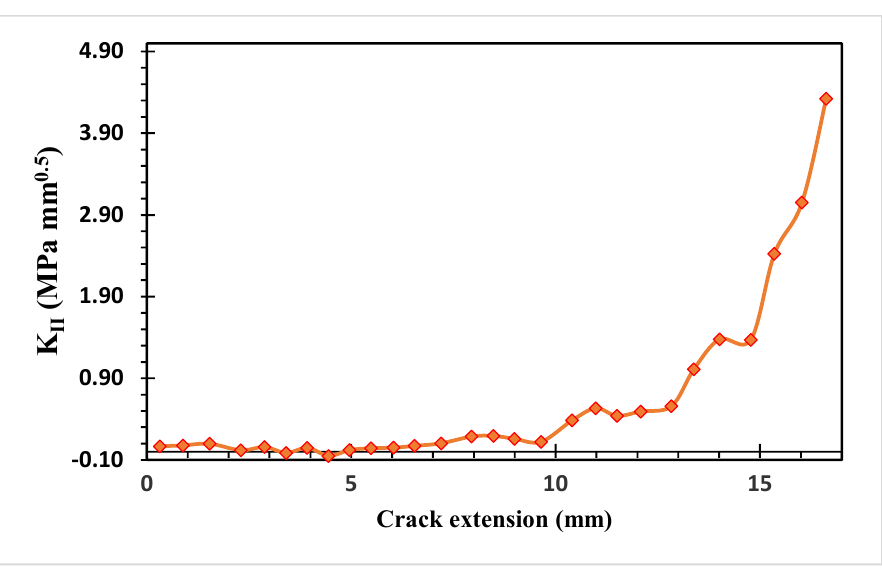
Figure 20. Second mode of stress intensity factors.